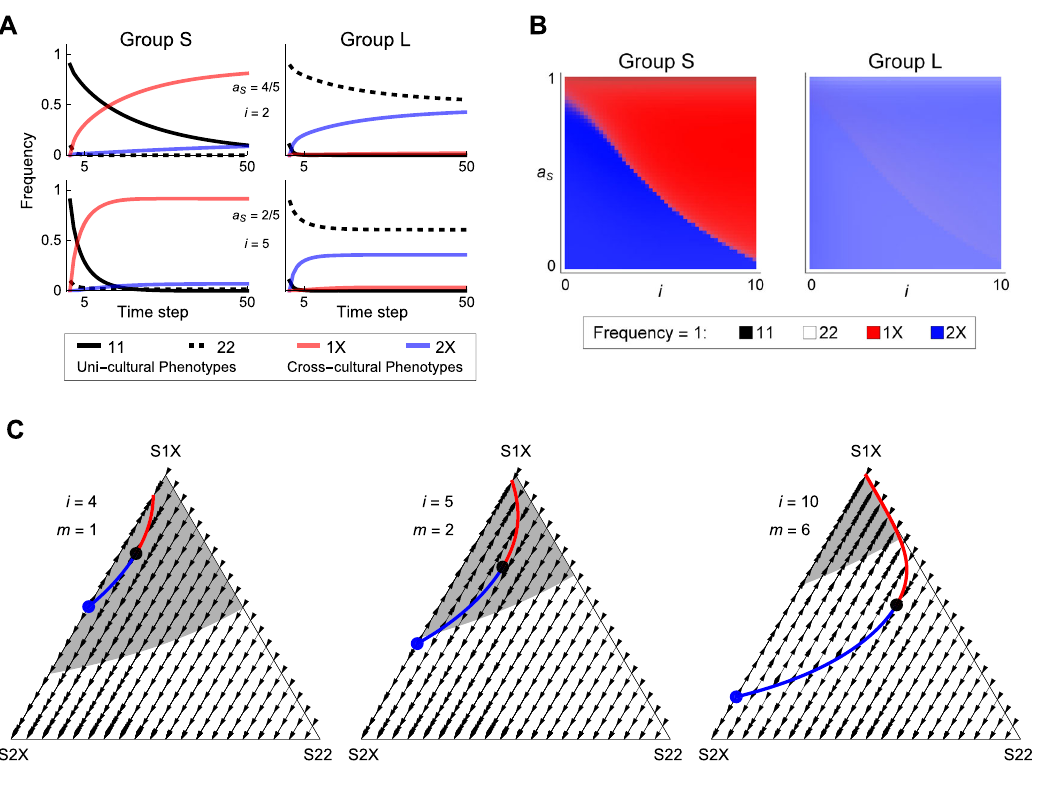
Fig. 2 Model simulations. A Phenotype frequency trajectories for model parameterizations in Fig. 1B, given greater valuation of group identity ( i ). B Phenotype frequencies after 100 time steps simulated from the model in A , but varying a S and i . Note that, after so many time steps, the 11 phenotype (black) is absent, and the 22 phenotype (white) remains at relatively high frequency in Group L (diluting the other colors, see also Appendix Fig. A.13). As the probability of in-group interaction ( a S ) decreases, greater in-group identity valuation ( i ) is required to maintain norm 1 at equilibrium. C Ternary plots for a simpli fi ed model ( p S 11 = 0, p L 22 = 1). Phenotype frequencies in group S are 1 at their respective vertices, and 0 at the opposite side. Unstable (blue) and stable (red) mixed equilibria contain the CCC phenotype S 1 X , where the blue line and the S 1 X − S 22 axis bound the basin of attraction for a given frequency of S 22. Points are the highest initial frequencies of S 2 X (blue) and S 22 (black) where S 1 X is still sustained at equilibrium. The intersection of the gray region (a function of m and i : Appendix B.3.2) and the basin of attraction is the set of phenotype frequencies where anticipated payoffs ~ w S 1 X > ~ w S 22 and ~ w “ Methods ” section), and thus inter-generational transmission of S 1 X is plausible. In this model, for a given frequency of S 22, the lowest S 2 X (see the frequency that the S 1 X phenotype can fall to, yet still be both sustained at equilibrium and potentially transmitted to the next generation, is represented by a point on the blue line or on the lower edge of the gray region, whichever is higher. At S 22 frequencies above that corresponding to the black point, S 1 X cannot be sustained, no matter what its frequency. Parameters a , b , c and μ match the bottom row of A